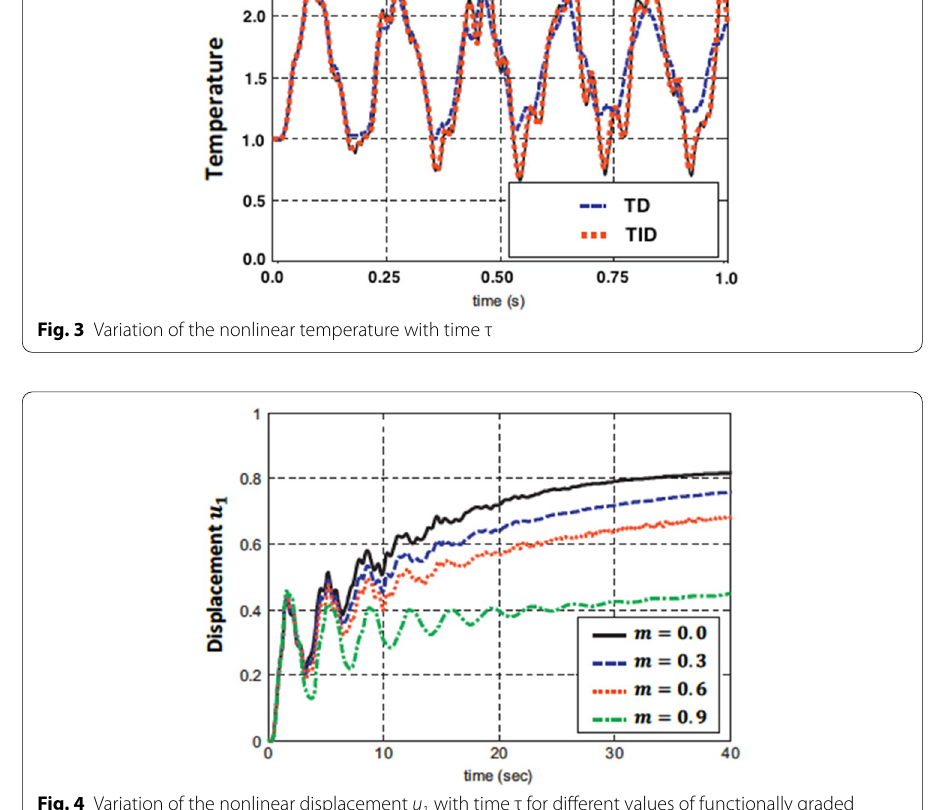
Fig. 4 Variation of the nonlinear displacement u 1 with time τ for different values of functionally graded parameter m